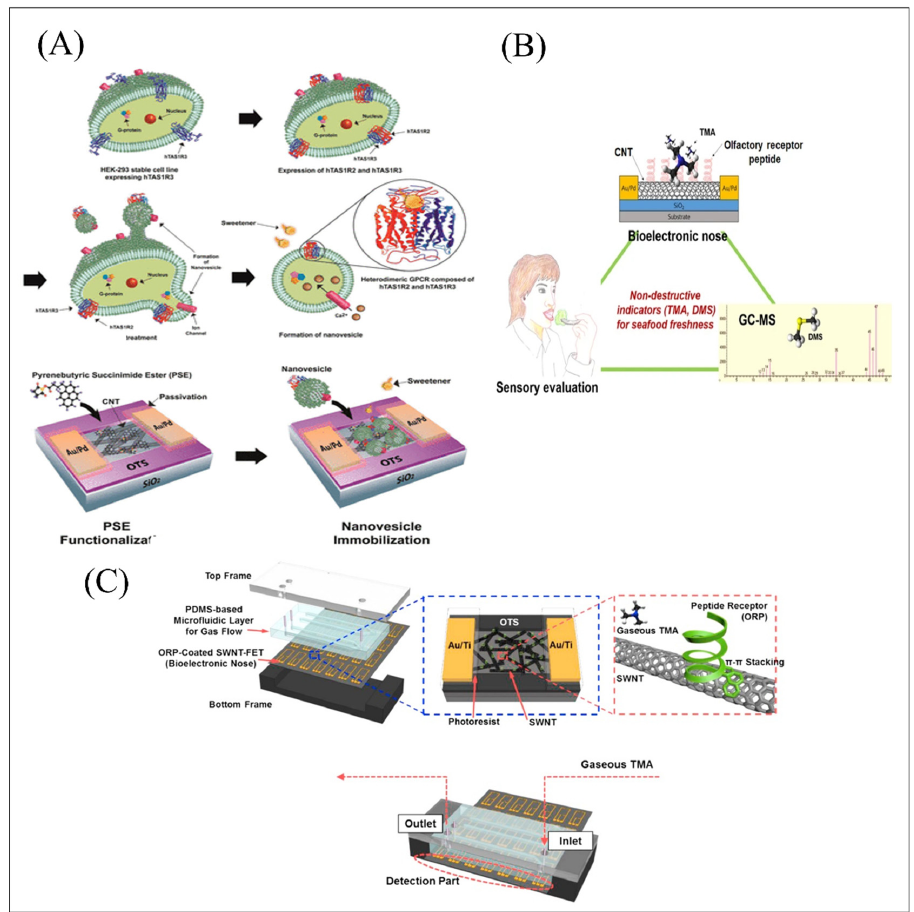
Figure 4. ( A ) Schematic diagram of the fabrication procedure of sweet taste biosensors functional- ized with nanovesicles containing heterodimeric human sweet taste receptors composed of hTAS1R2 and hTAS1R3 through π - π interactions. Reproduced with permission from Ref. [75]. ( B ) A triangle study of a human evaluation test, instrumental analysis (GC-MS), and a CNT-FET bioe- lectronic nose functionalized with olfactory receptors for exploring non-destructive sensing of sea- food freshness. Reproduced with permission from Ref. [55]. ( C ) Schematics of SWNT-FETs com- bined with μ BN system for TMA molecule detection. Reproduced with permission from Ref. [70].